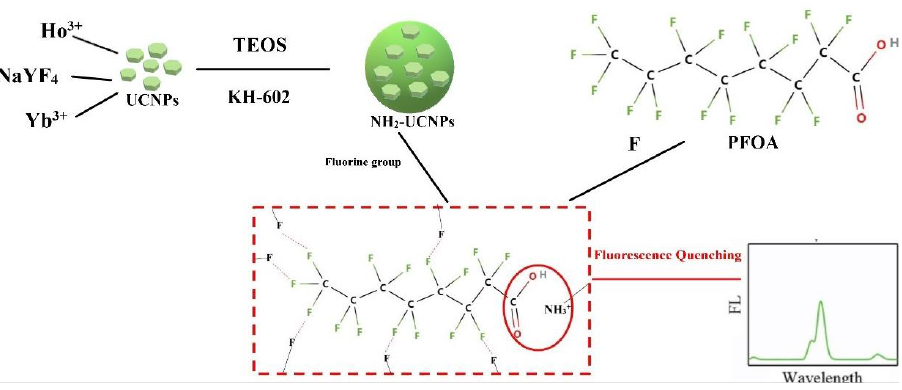
Figure 13. Schematic diagram of detecting PFOA.